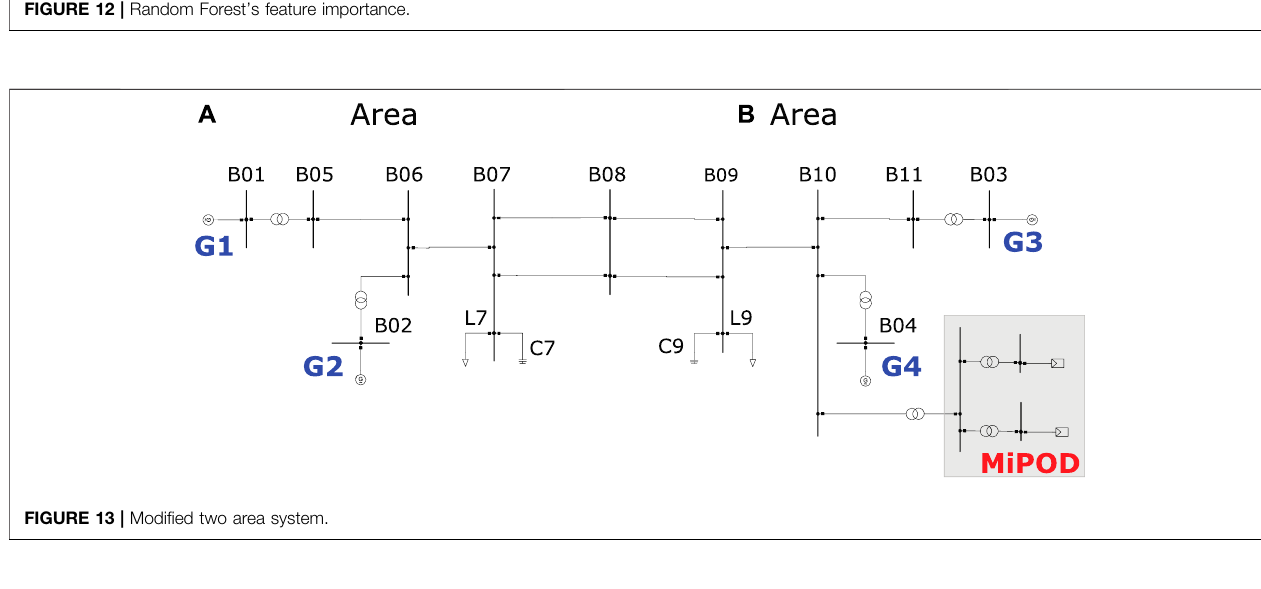
TABLE 2 | List of feedback